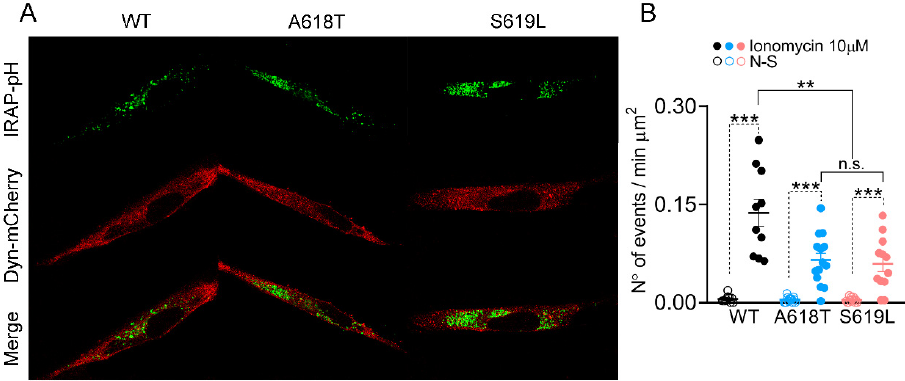
Figure 3. pHluorin signals in C25 myoblasts overexpressing WT dynamin-2 or the p.A618T or p.S619L mutations. C25 myoblasts were transfected with IRAP-pHluorin together with alternatively WT, p.A618T or p.S619L dynamin-2-mCherry plasmids. Exocytosis induced with 10 μ M ionomycin was monitored 48 h later by TIRFM. ( A ): Confocal images of cells expressing IRAP-pHluorin (green) together with WT, p.A618T or p.S619L dynamin-2 (red). Scale bar = 20 µ m. ( B ): Frequency of events in C25 myoblasts overexpressing WT (black; 10 cells), p.A618T (blue; 12 cells) or p.S619L (red; 14 cells) dynamin-2 in non-stimulated conditions (empty dots) or stimulated with 10 µ M ionomycin (filled dots). Each dot represents the average frequency of events for individual cells from at least three independent cultures. Horizontal lines indicate means with SEM. *** p < 0.001 compared to the corresponding non-stimulated cells (Student’s t -test), ** p < 0.002 compared to WT dynamin-2 overexpressing cells stimulated with 10 µ M ionomycin (ANOVA test followed by Bonferroni multiple comparison test). n.s., non-significant